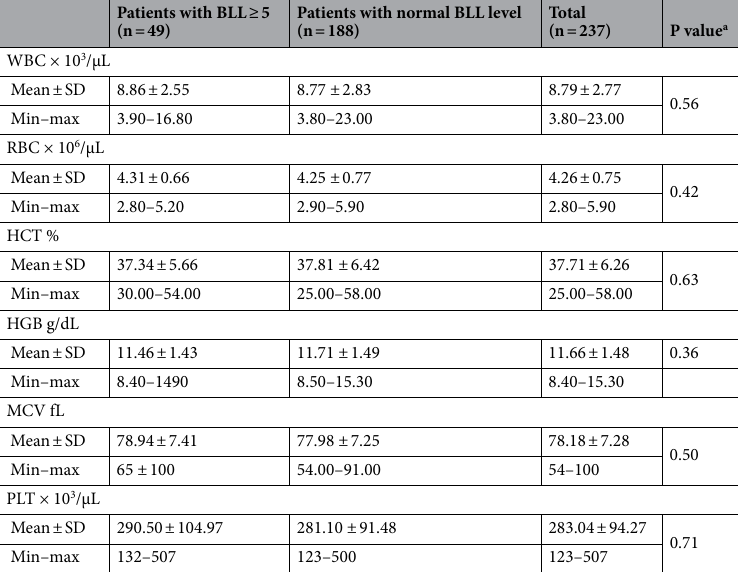
Patients with BLL ≥ 5 (n = 49)